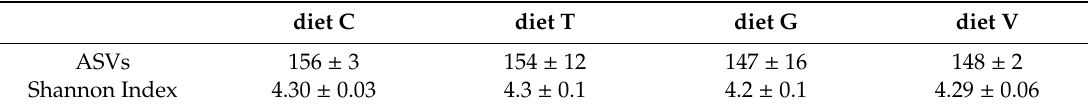
Table 3. Amplicon sequence variants (ASVs) number and Shannon Index calculated for each tested condition. Values are reported as average ± standard error.